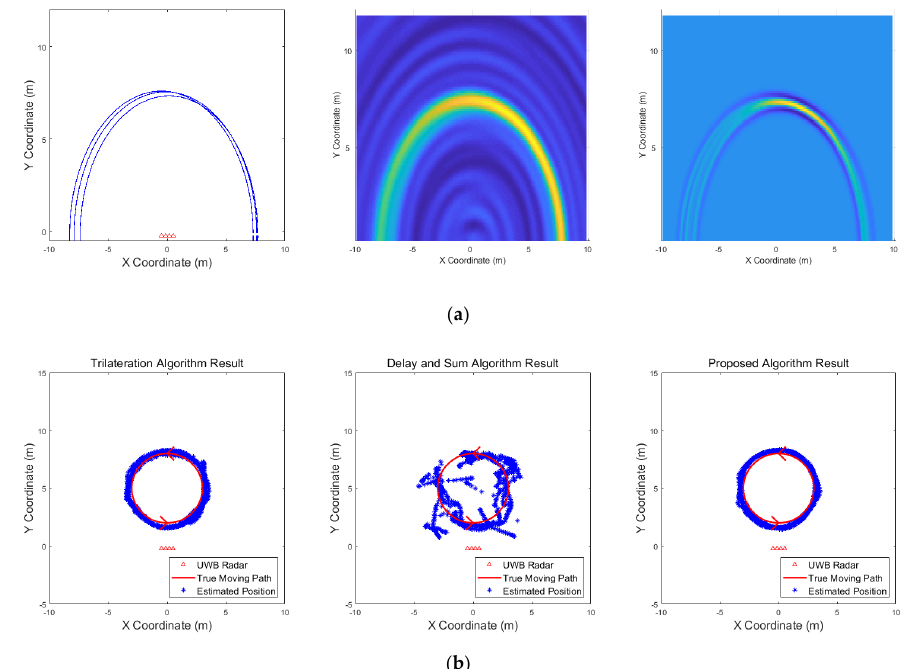
Figure 17. Simulation results when one target moves in a circle (Scenario 9): ( a ) instantaneous results of position estimation step according to the positioning algorithm; ( b ) results of the radar system for the entire simulation.